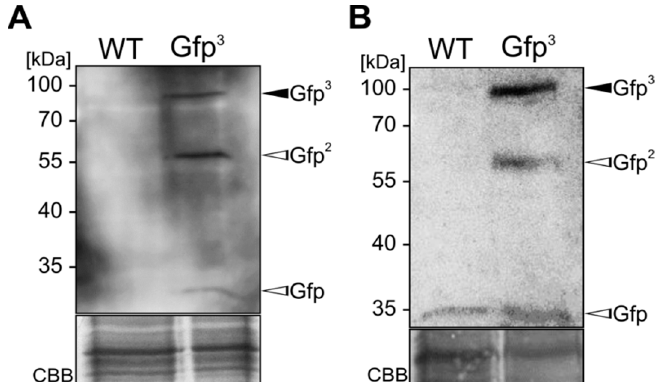
Figure 3. Western blot analyses using an α Gfp nanobody produced in U. maydis . ( A ) Detection of triple-Gfp (Gfp 3 ) by Western blot analysis using the α GfpNB-Cts1 fusion protein enriched from cell extracts of strain AB33kex2 Δ / α GfpNB-Cts1; ( B ) Detection of Gfp 3 by Western blot analysis using α GfpNB-Cts1 enriched from culture supernatants of strain AB33kex2 Δ / α GfpNB-Cts1. Besides Gfp 3 (black arrowheads) its degradation products Gfp 2 and single Gfp (open arrowheads) were also detected.